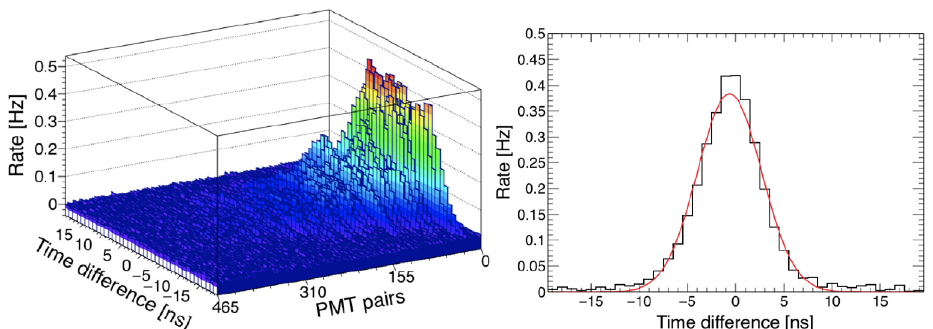
Figure 2. Left: distribution of time di ff erences between the hit times for all PMT pairs in DOM 1 for one physics run. The PMT pairs are ordered according to the angular distance between PMTs. Right: distribution of time di ff erences between the hit times of two adjacent PMTs in DOM 1 for one physics run. The Gaussian function, represented by the red line, is the result of the simultaneous fit. The baseline due to combinatorial background has been subtracted from the data.